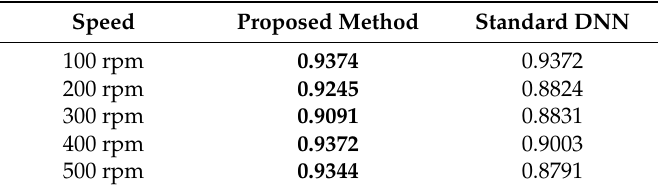
Figure 8. Diagnostic accuracy under 25 working condition. Table 3. Averaged accuracy under 5 speeds.